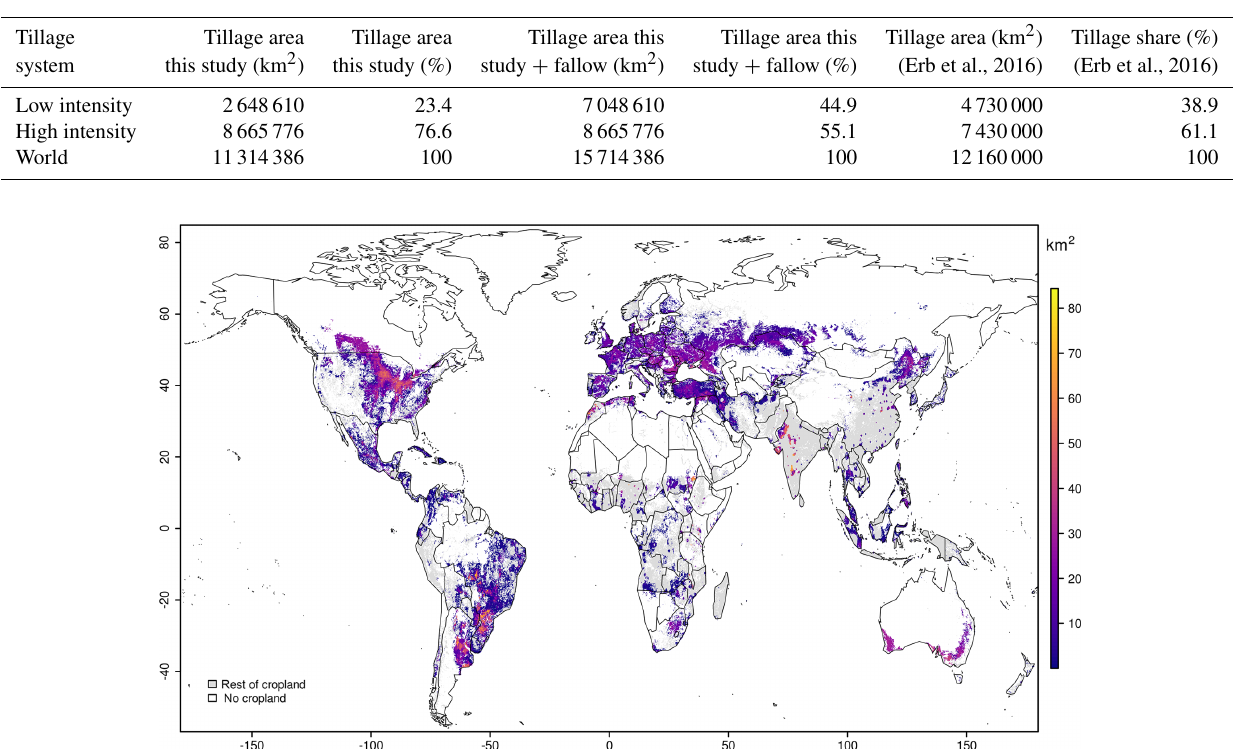
Figure 9. Scenario Conservation Agriculture area (km 2 ) (colored) on total cropland (grey) per grid